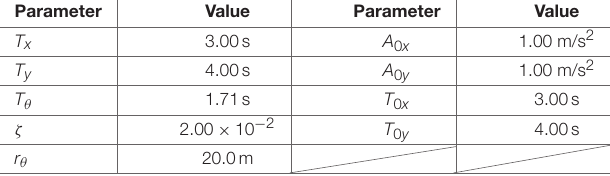
TABLE 1 | Parameter values for numerical